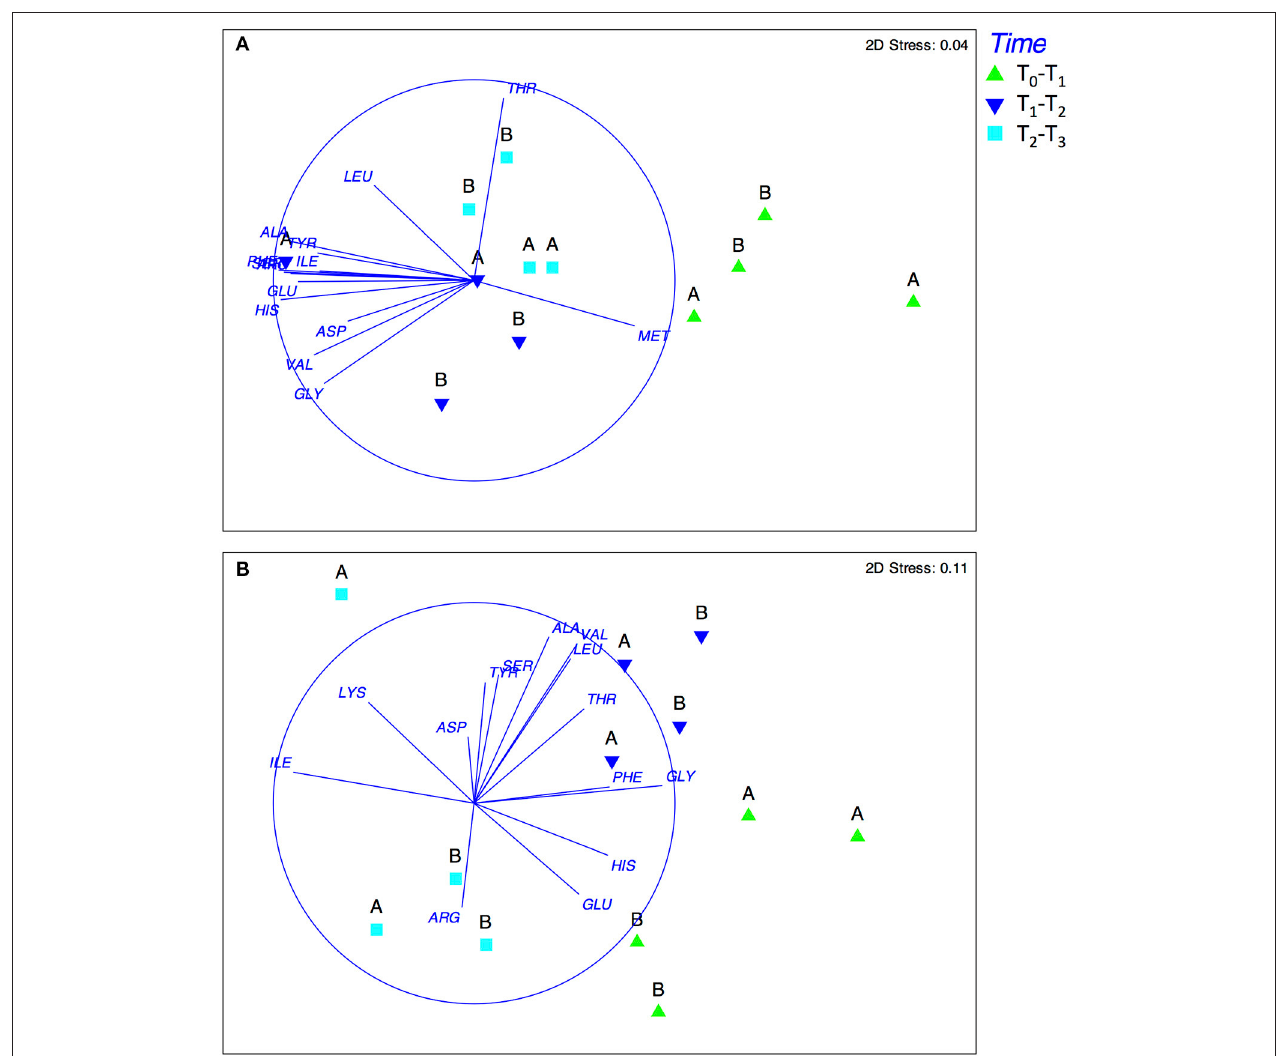
FIGURE 5 | Non-metric multidimensional scaling analysis (MDS) of the amino acid profile based on Euclidean distance in late summer (A) and spring (B) . In (A) the treatment was enriched with dissolved compounds excreted by copepods fed with a 20–150- µ m size-fraction diet. In (B) the treatment was enriched with dissolved compounds excreted by copepods fed with a < 20- µ m size fraction